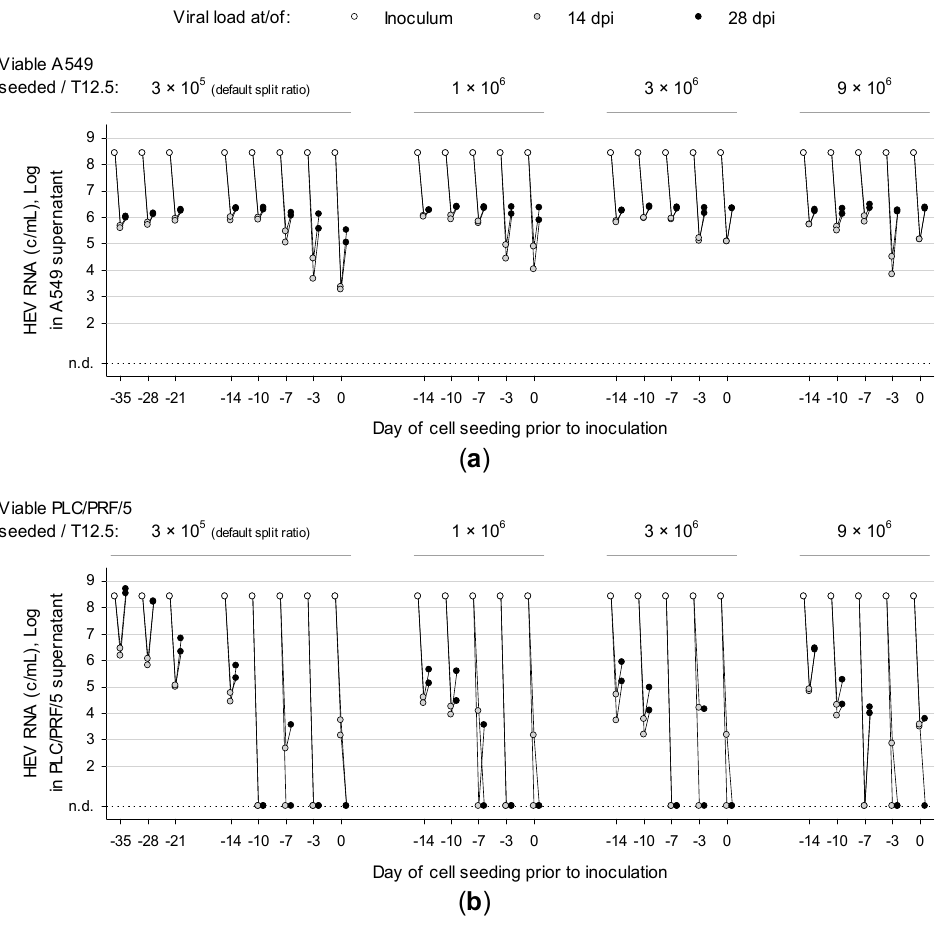
Figure 2. Density and time point of cell seeding prior to inoculation affect the success of infection and consequent viral load. ( a ) A549 and ( b ) PLC/PRF/5 were seeded at different concentrations and time points prior to inoculation. Cells were inoculated in duplicates with isolate 47832c. Supernatants were tested for HEV RNA at day 14 and 28 post-inoculation. Dpi, days post inoculation; n.d., not detected. Generally, we observed a tendency to more reliable infection and higher viral loads when more cells are seeded earlier prior to inoculation, generating more susceptible three-dimensional cell layers. Therefore and to standardize the approach, cell seeding was set to 1 × 10 5 viable cells per cm 2 at 14 days prior to